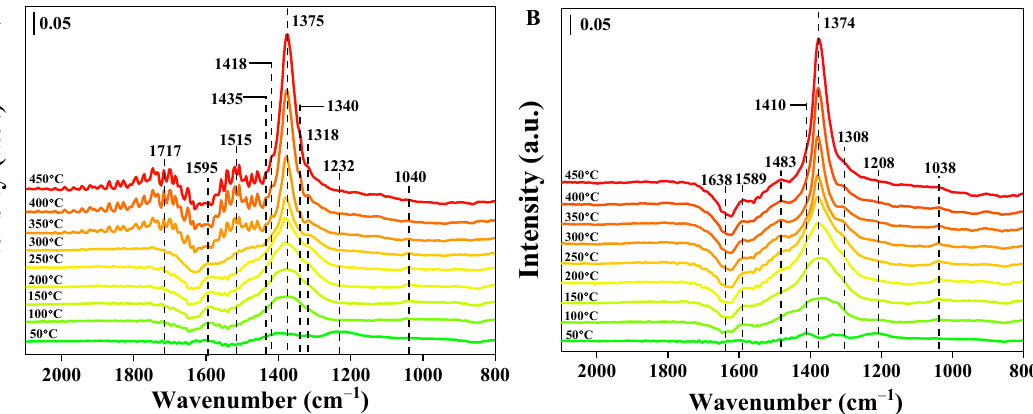
Figure 10. In situ DRIFT spectra of NO x absorption on ( A ) the Ni 1.5 Co 0.5 AlO catalyst and ( B ) the Pt 2 /Ni 1.5 Co 0.5 AlO catalyst.